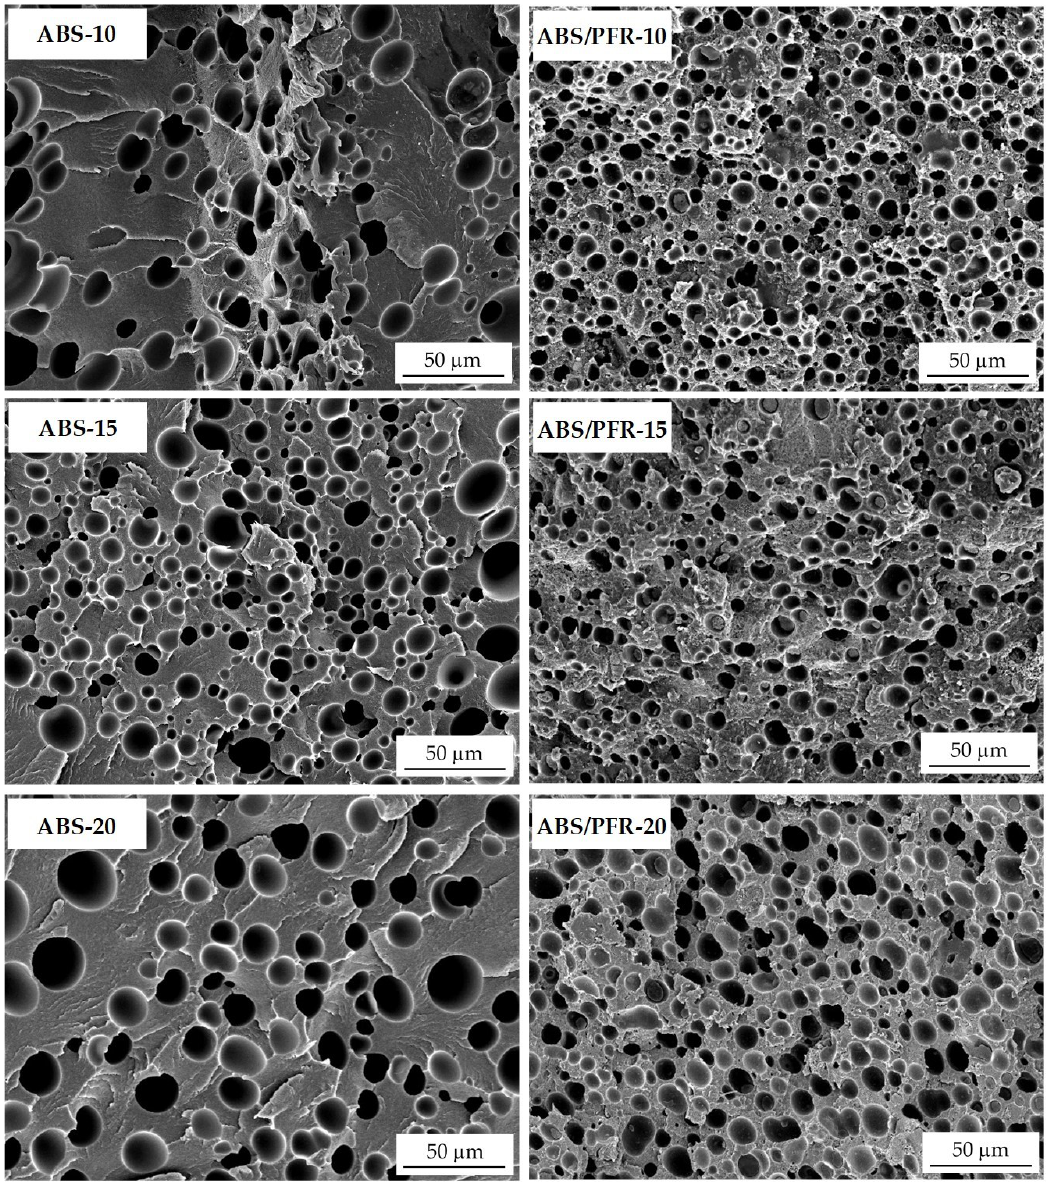
Figure 3. SEM images showing the characteristic core cellular morphology of ABS and ABS/PFR foams. In terms of PFR particles distribution, it can be seen by observing the characteristic SEM images presented in Figure 4 that, although the presence of particles having very different sizes, PFR particles were uniformly distributed throughout the cell walls of ABS/PFR